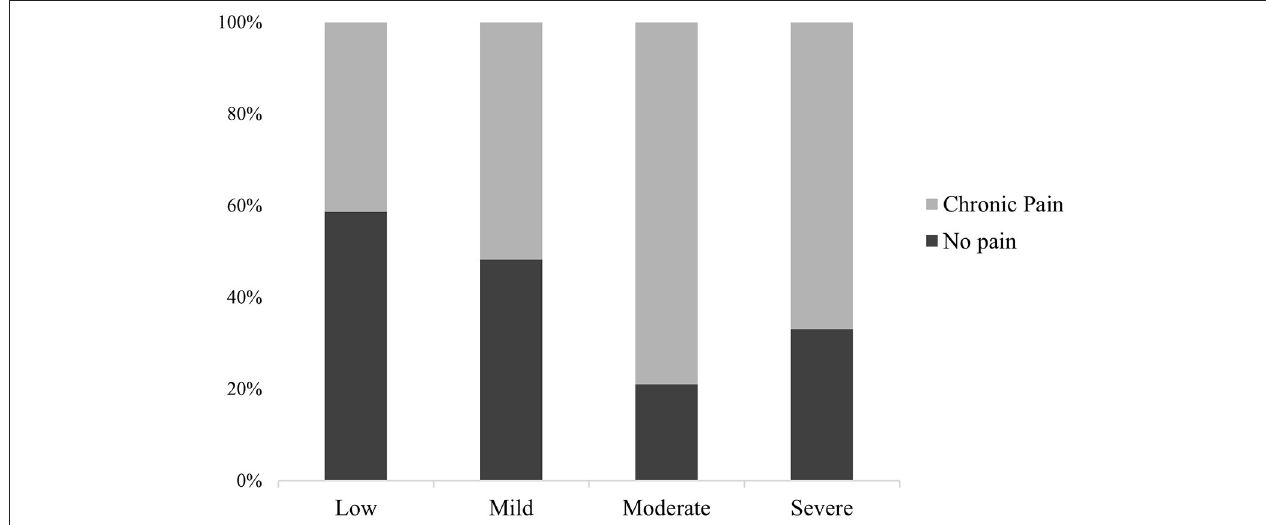
FIGURE 2 | Descriptive distribution of participants with and without CP according to their distress level: low (0–2), mild (3–5), moderate (6–8), and severe (9–12).